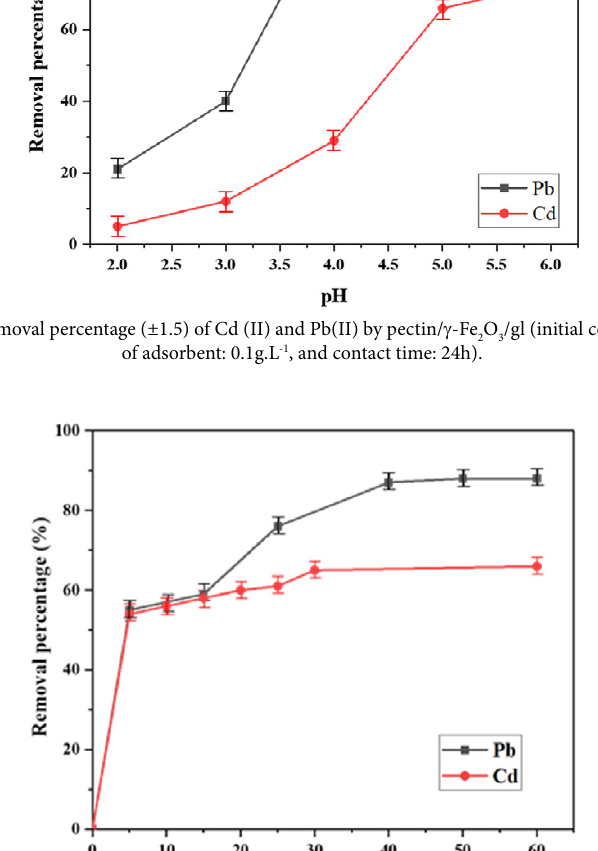
O /gl (pH:5, initial concentration: 2 3